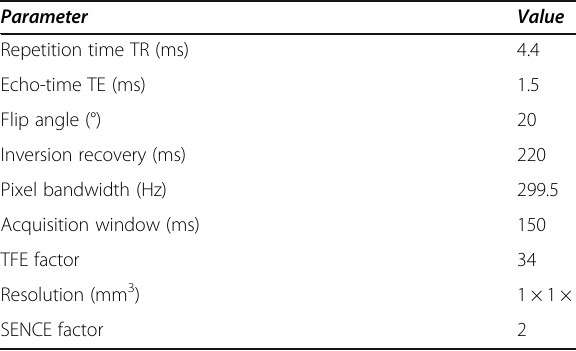
Table 1 Acquisition parameters for the